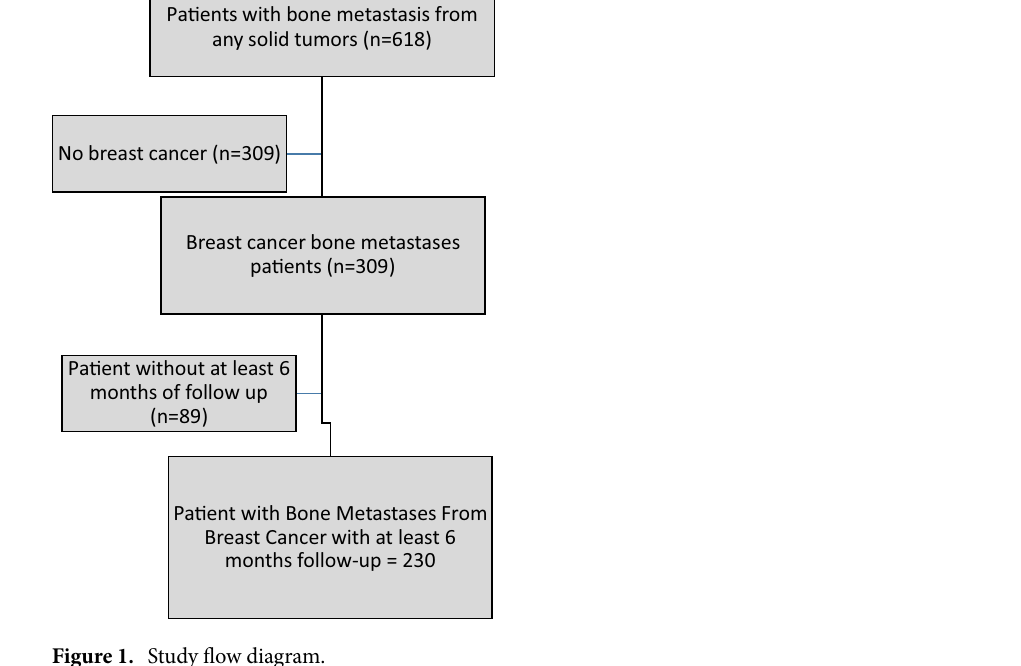
Figure 1. Study flow